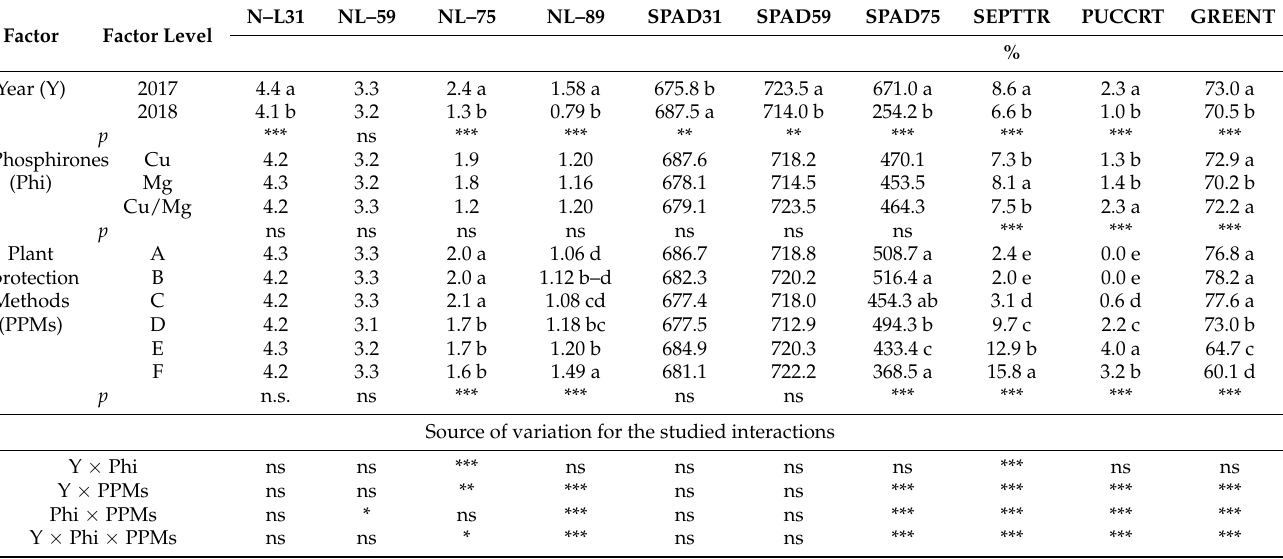
Table 4. Nitrogen content in leaves, SPAD indices, and winter wheat infestation by pathogens during the growing season.